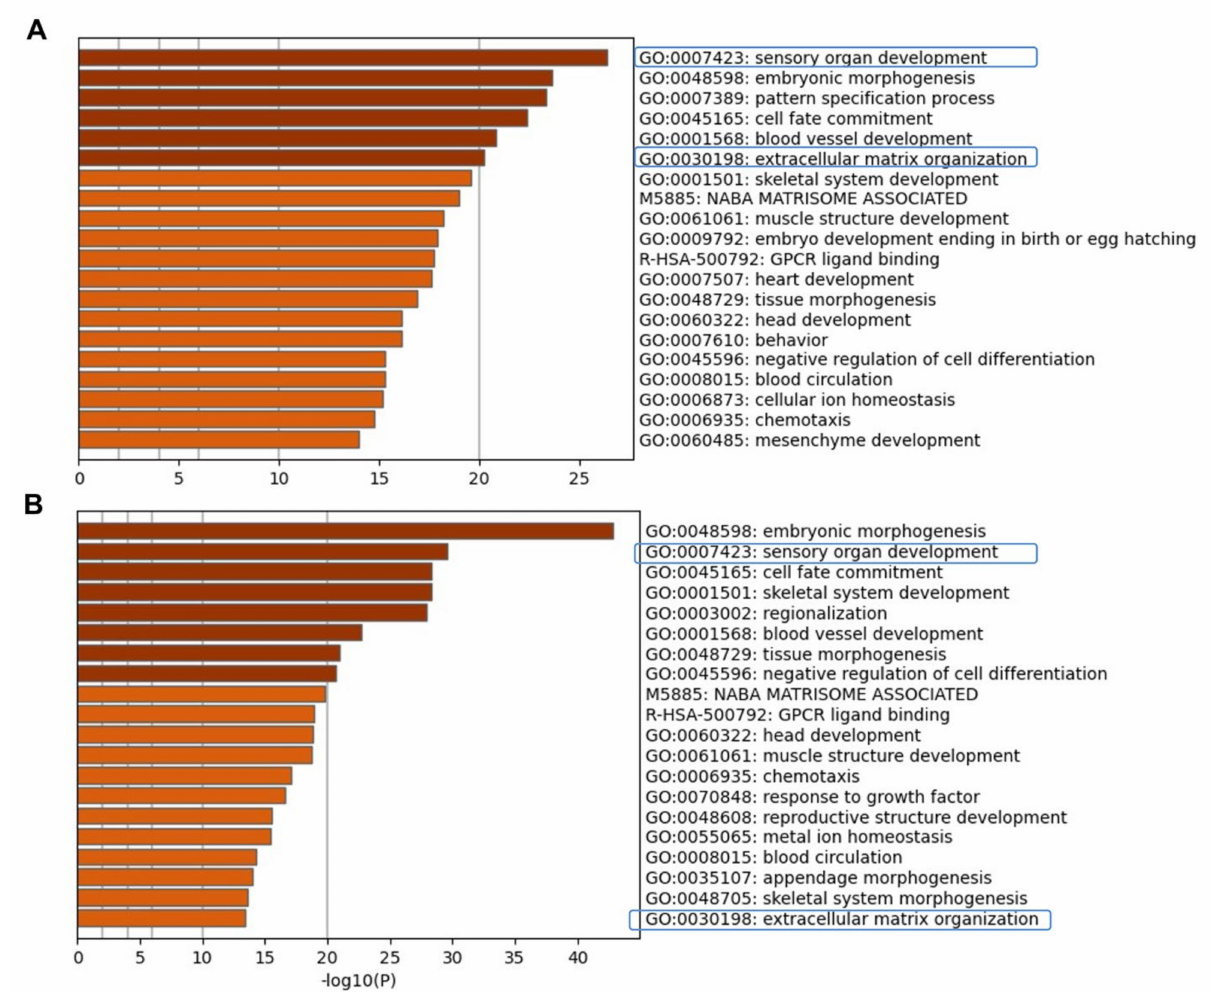
Figure 3. Visualizations of functional enrichment. Metascape bar graph for viewing top enriched ontolog clusters in the lists of up-regulated genes at day 6 ( A ) and at day 13 in vitro ( B ) relative to undifferentiated hiPSCs. Metascape enrichment analysis pinpointed the top most significantly pathways that include sensory organ development, embryonic morphogenesis, pattern specification, and ECM organization as highly enriched in human otic/placodal cells at day 6 and otic sensory cells at day 13 differentiated cell